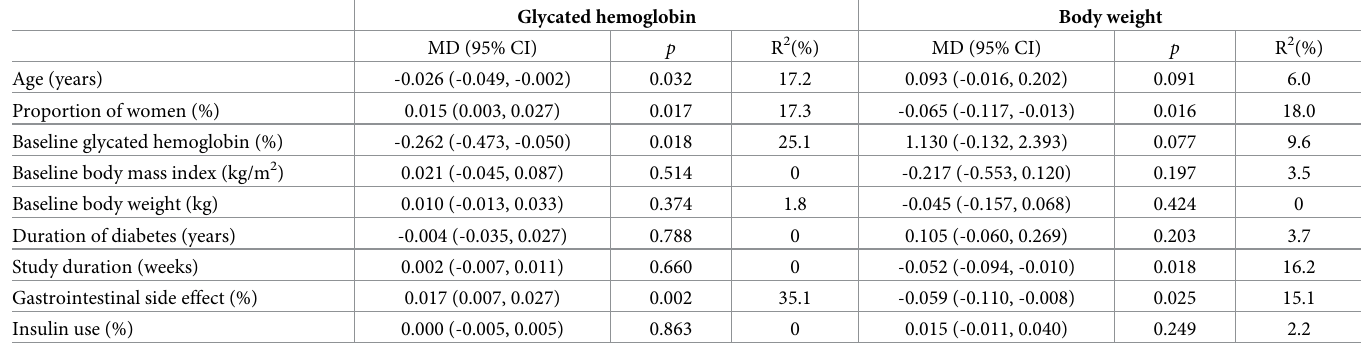
Table 1. Univariate meta-regression of the effects of glucagon-like peptide-1 receptor agonists on glycated hemoglobin levels and weight